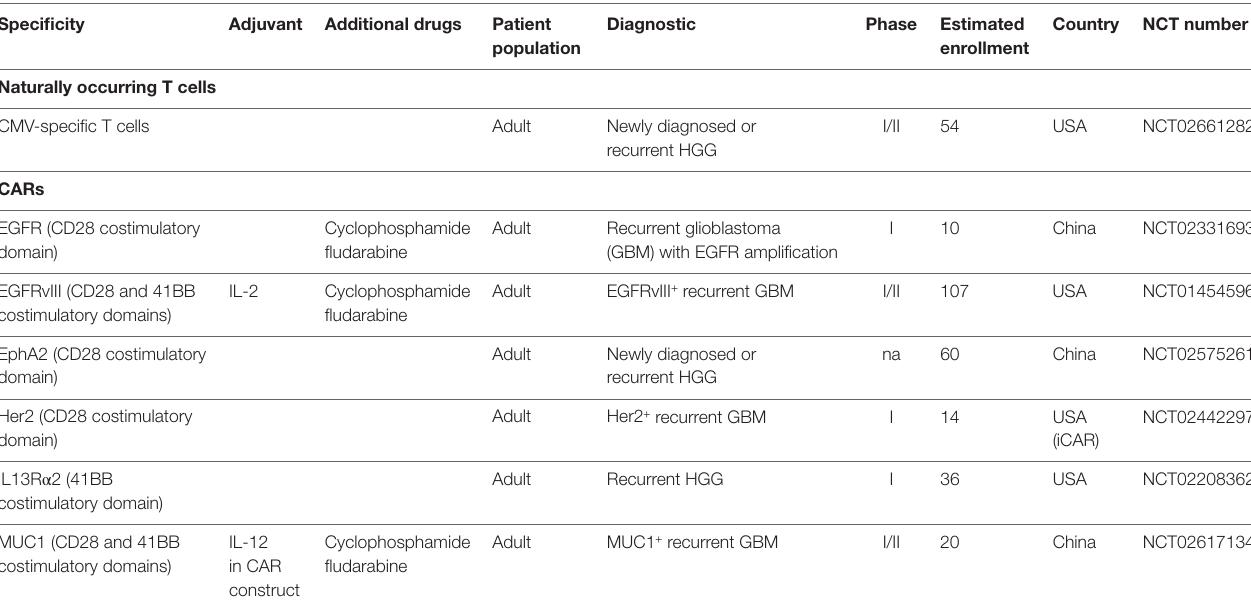
TABLe 2 | Currently ongoing cell therapy trials in tumors located in the